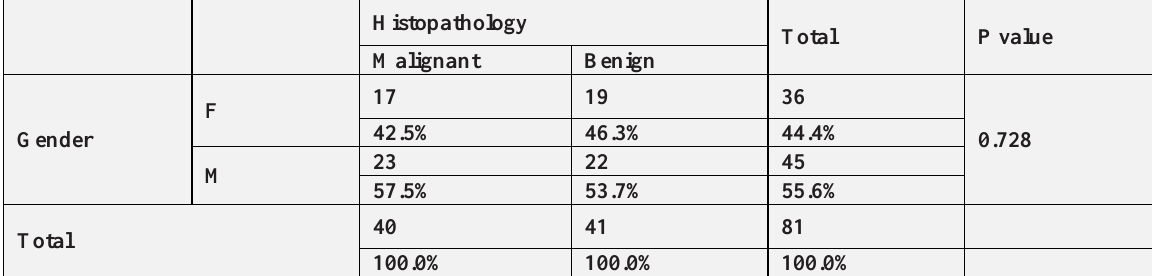
Table (2): The number and percentage of male and female patients according to